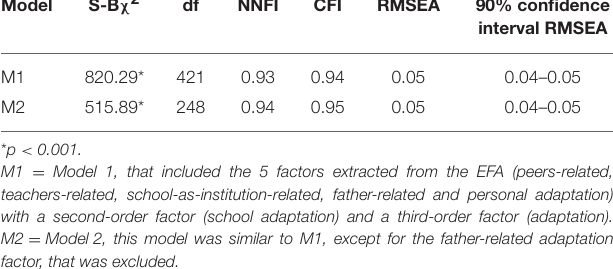
TABLE 3 | Goodness-of-fit indexes of the models resulting from the CFAs.